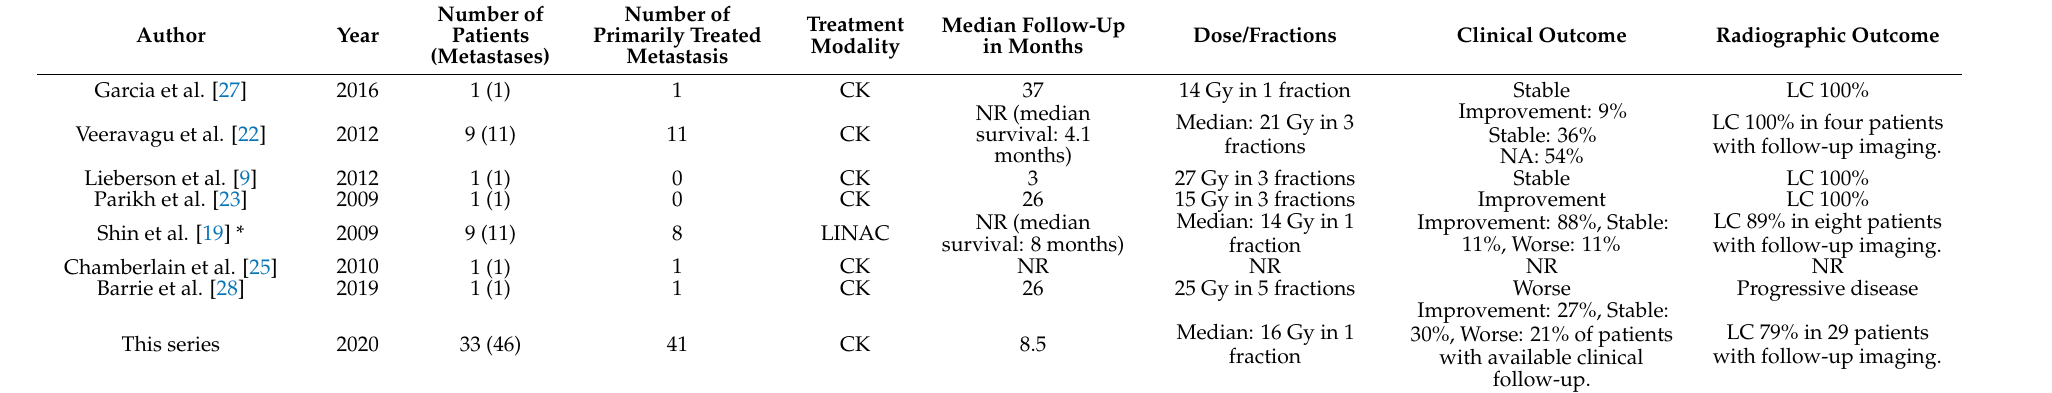
Table 3. Literature review of intramedullary metastases primarily or secondarily treated with